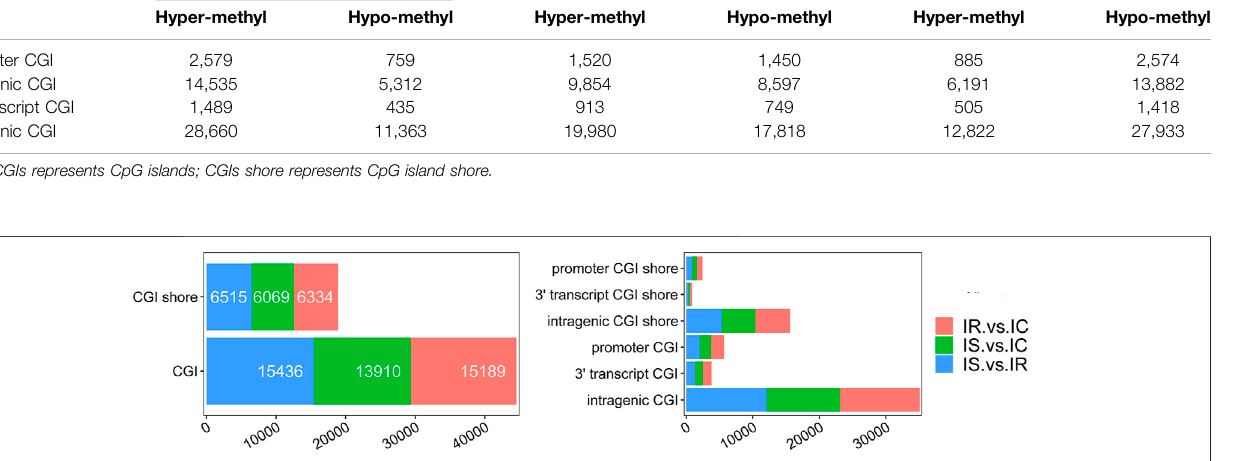
TABLE 3 | The distributions of the signi fi cant CGIs methylations of the IR, IS, and IC groups. IR vs. IC IS vs. IC IS vs. IR